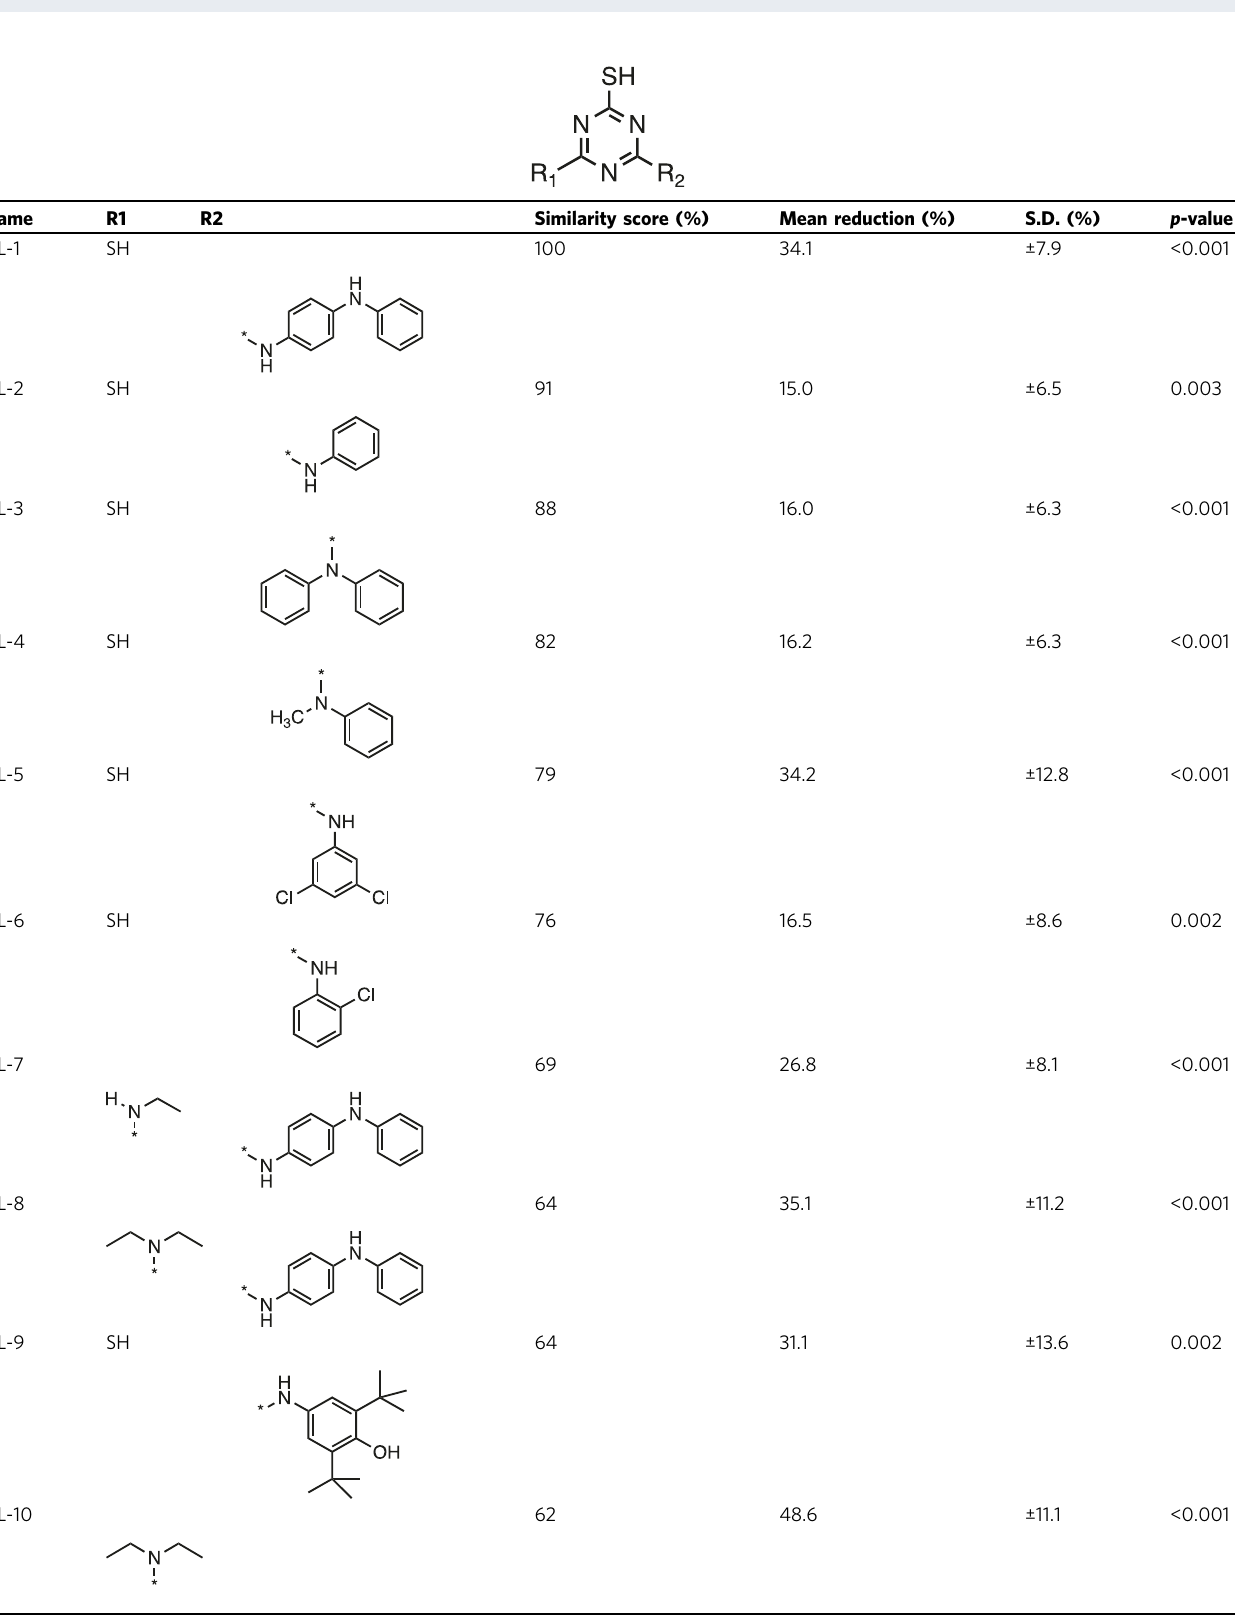
Table 1 Activity of structurally related compounds within the SC 3